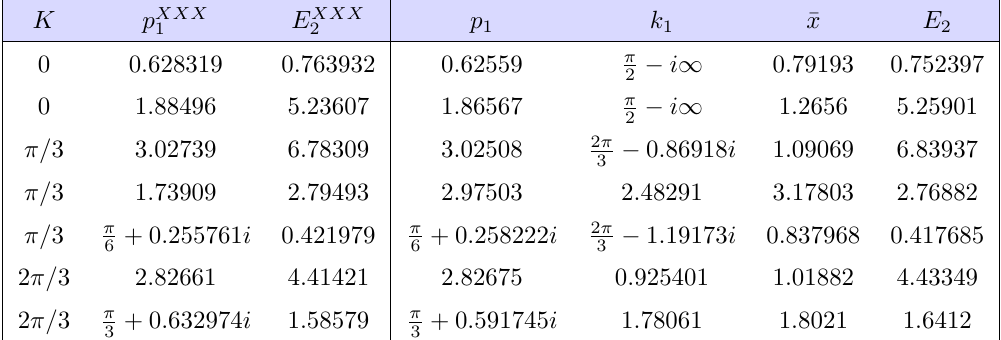
momenta can be found as p = K − p and similarly for 2 2 1